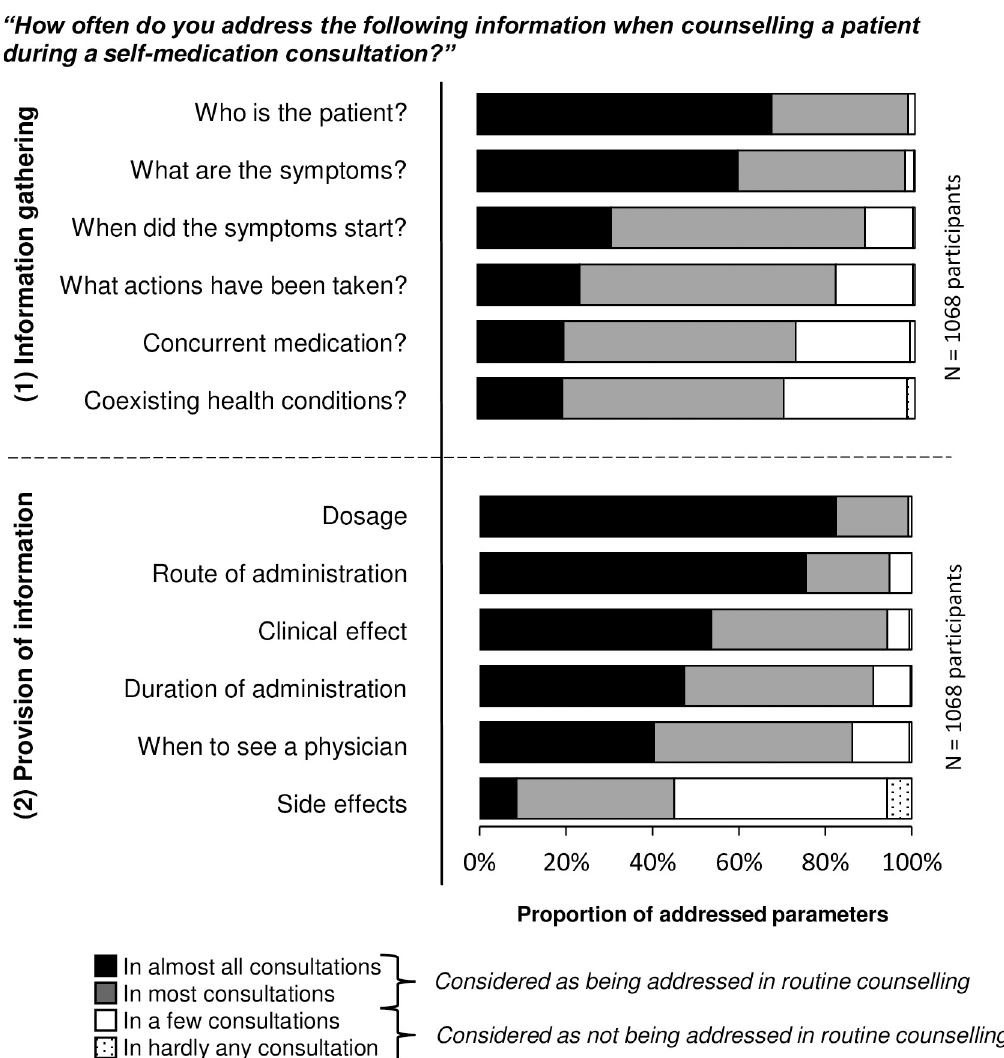
Fig 4. Rated frequency (III) of addressing the twelve counselling parameters during a self-medication consultation. The twelve parameters were rated by 1068 respondents in the self-report (study part